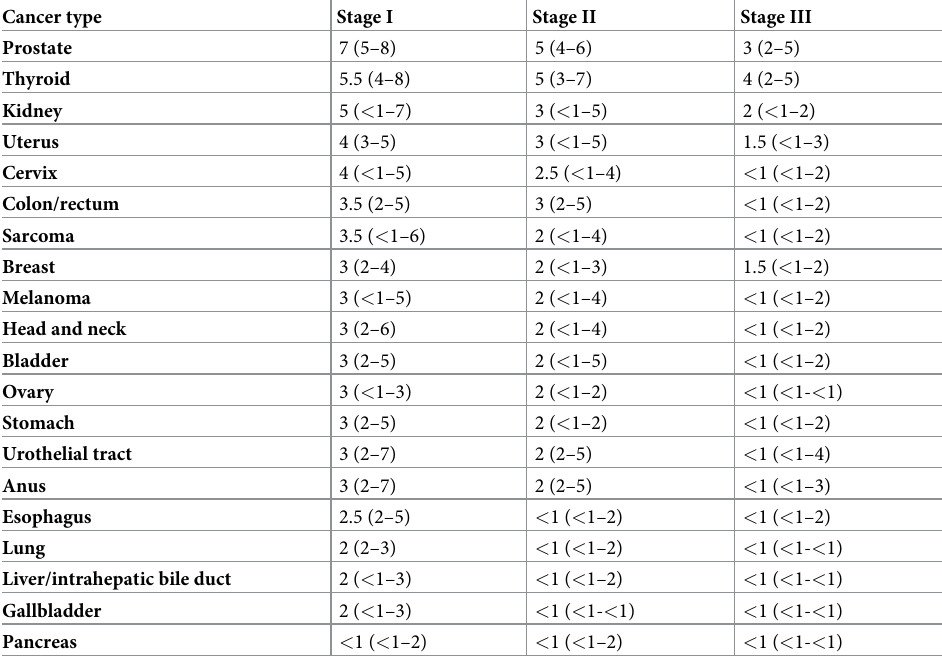
Table 2. Estimated median (range) number of years for each cancer type to progress from one stage to the next.